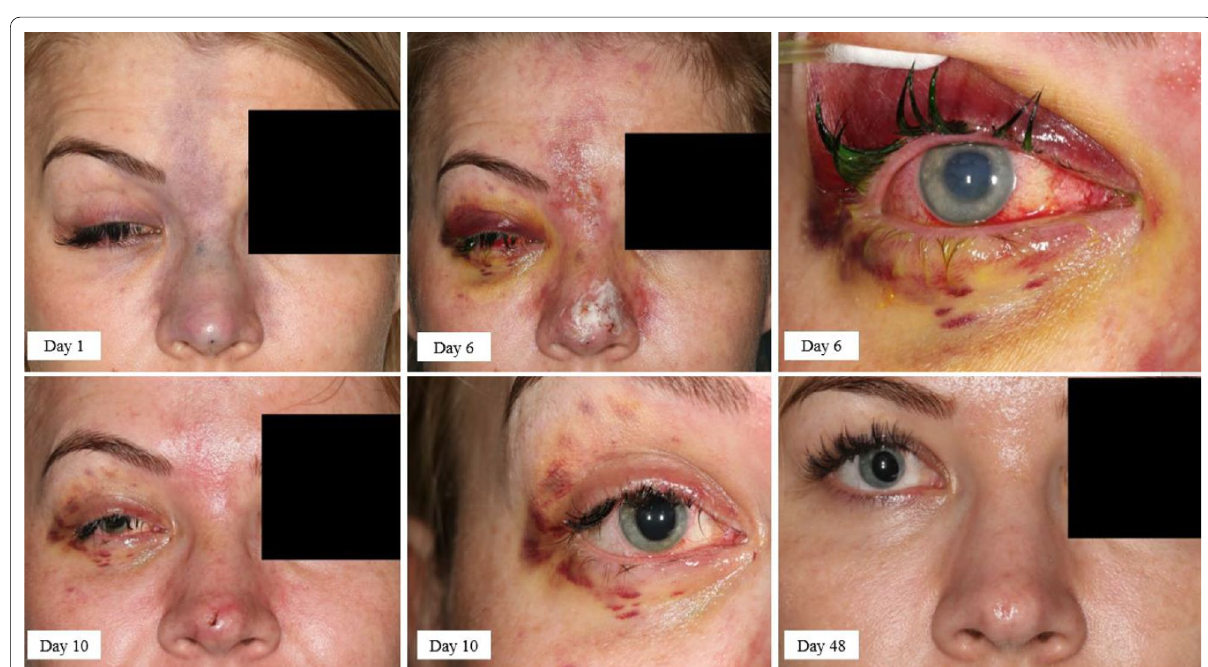
Fig. 5 Early and late macroscopic findings following rhinoplasty and cheek augmentation with a hyaluronic acid filler. The patient is shown on post‑injection days 1, 6, 10 and 48, demonstrating the oculomotor nerve palsy on the right side and skin necrosis beginning. A small scar at the tip of the nose and an irregular pupillary margin on the right side persisted (day